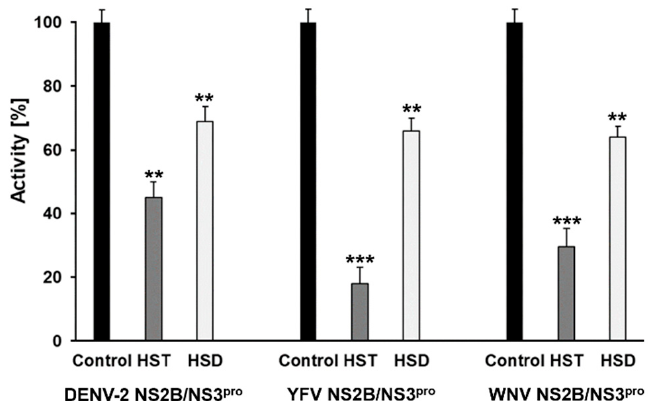
Figure 2. Primary inhibition test using HST and HSD as inhibitor molecules against flavivirus proteases. DENV2, YFV, and WNV NS2B/NS3 pro enzymatic activity [%]. Final concentration of the compound was set to 10 µ M. HST inhibited the proteases activity between 55% and 80%. Contrary to this, HSD inhibited the proteases activity by about 30%. The data shown are the mean ± SD from 3 independent measurements ( n = 3). Asterisks mean that the data differs from the control (0 µ M inhibitor) significantly at p < 0.01 (**) and p < 0.001 (***), level according to ANOVA and Tukey’s test. HSD shows inhibition of the three tested proteases to be around